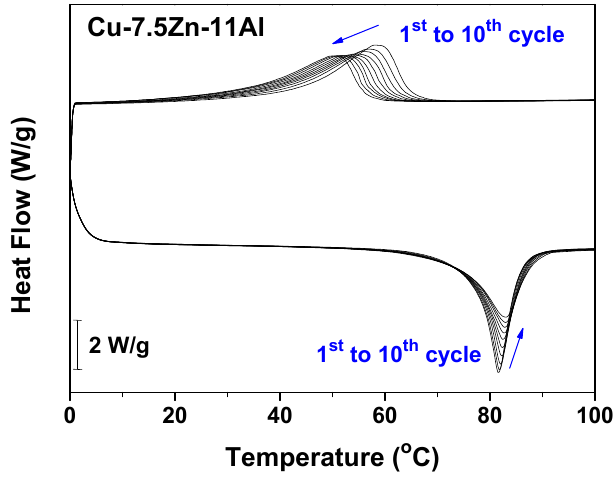
Figure 5. DSC curve of Cu-7.5Zn-11Al SMA determined for 10 repeating heating and cooling cycles.